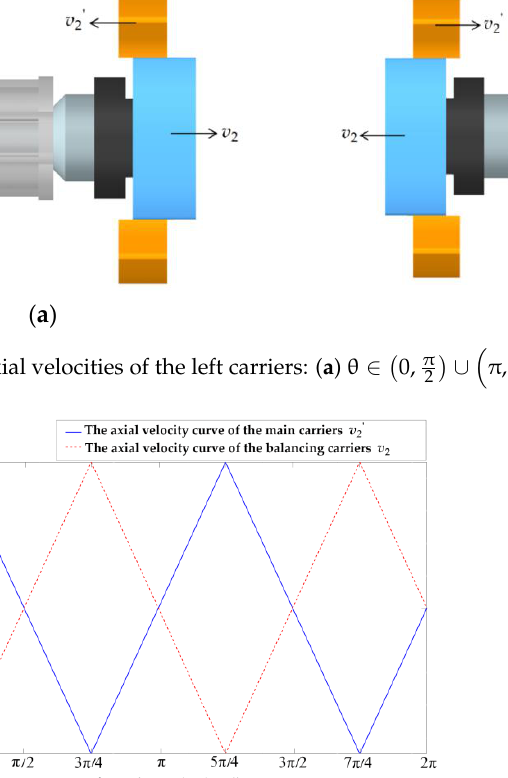
Figure 4. The axial velocity of the carriers.